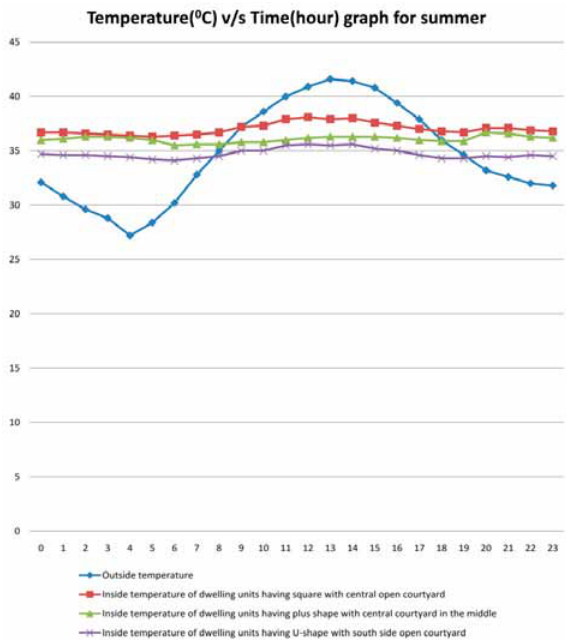
fig. 17. recorded average temperatures in week from 29 th May to 4 th june during hottest period of